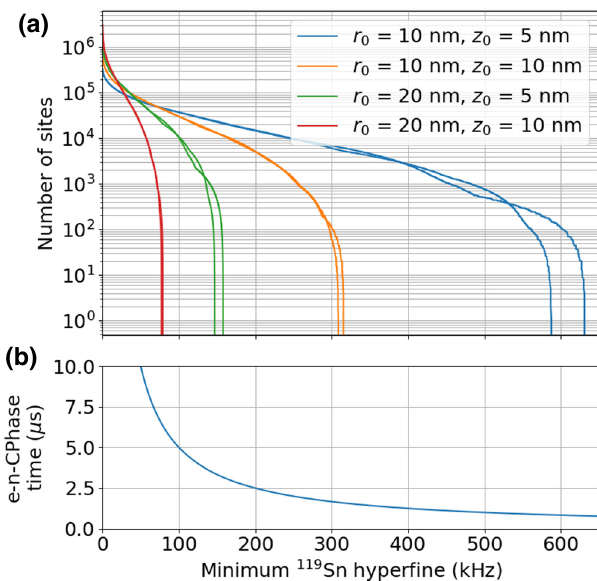
FIG. 3. (a) The number of lattice site locations at which 119 Sn would have a hyperfine interaction above the corresponding minimum strength in frequency units (the energy multiplied by Planck’s constant) for various quantum dot shapes and valley- phase extremes using our estimated value of η Sn = 996.4. We use the simple wave-function model of Eq. (5) as a basic char- acterization of quantum dot sizes. The two curves for each color correspond to the extreme valley phases of θ v ∈ { 0, π } , where = 0 yields the largest hyperfine strength at the vertical center θ v of the quantum dot. (b) The minimum (i.e., in the limit of instan- taneous hyperfine interaction on-off switching) e-n-CPhase gate time in correspondence with each hyperfine strength (0.5 / Ah , where A is the hyperfine energy and h is Planck’s